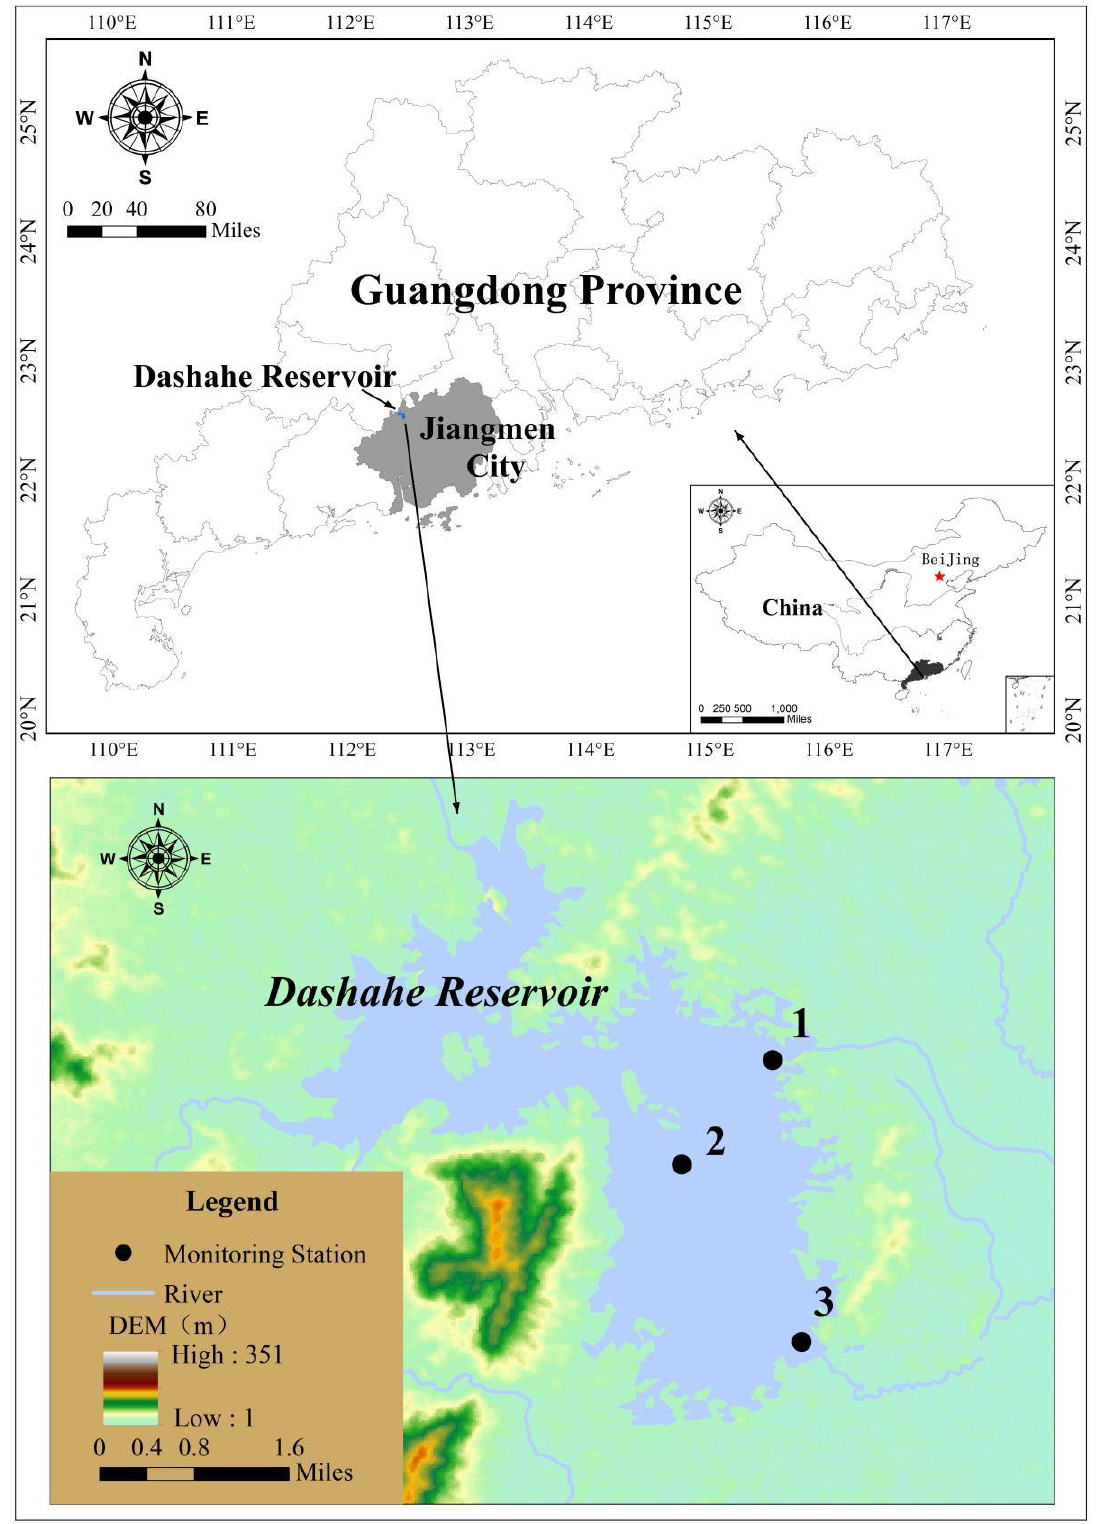
Figure 1. Location of the Dashahe Reservoir.